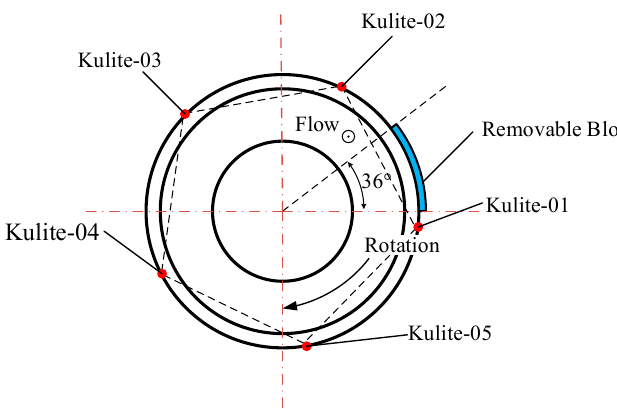
Figure 10. Relative position in circumference of the PVDF sensor array and Kulite transducers.